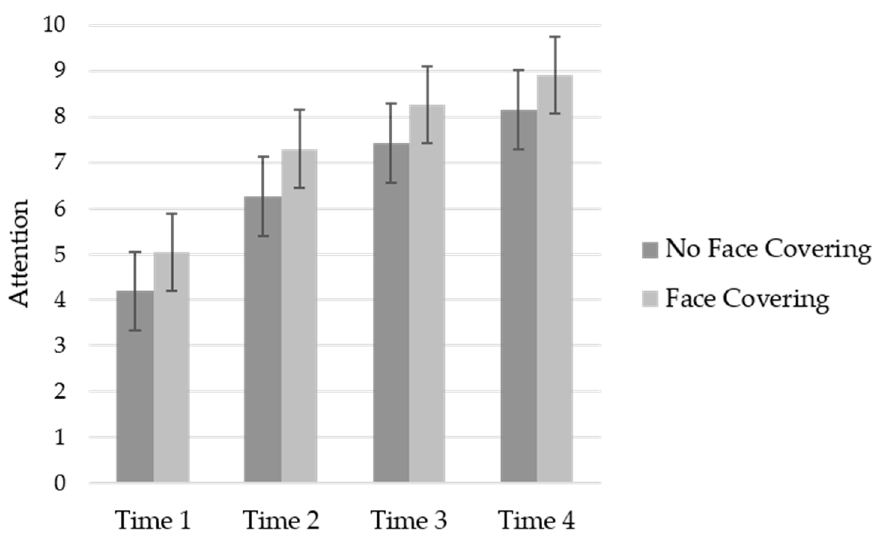
Figure 3. Mean attention across time by condition.